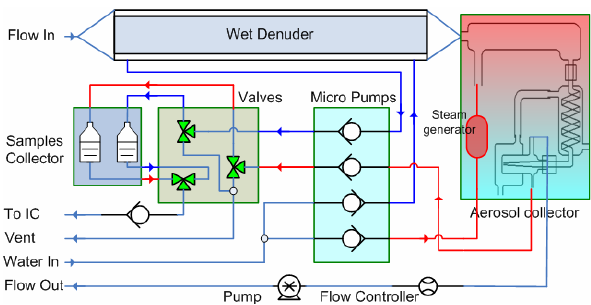
Fig. 2. Overview of the improved GAC sampler equipped with a newly designed aerosol Fig.2. Overview of the improved GAC sampler equipped with a newly designed aerosol collector